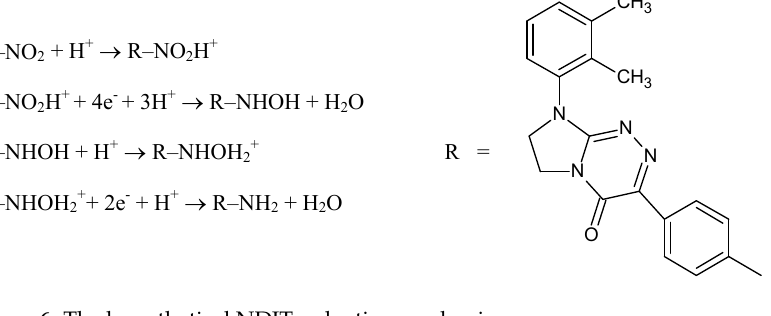
Figure 6. The hypothetical NDIT reduction mechanism.